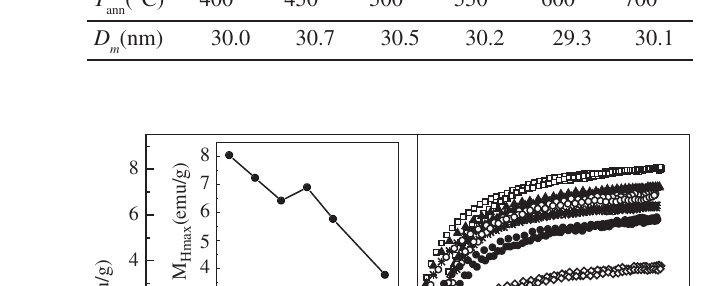
Table 1. Average Fe particle sizes D ent T values. ann